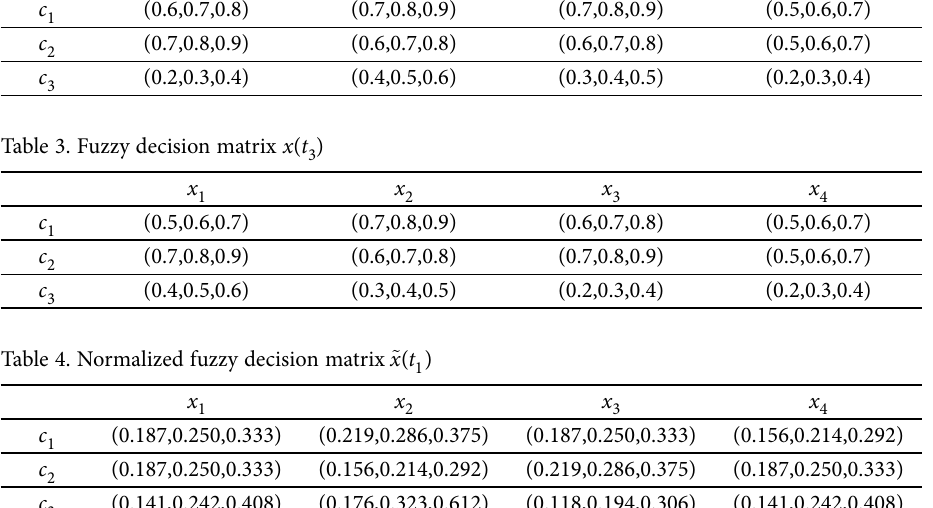
Table 2. Fuzzy decision matrix x ( t